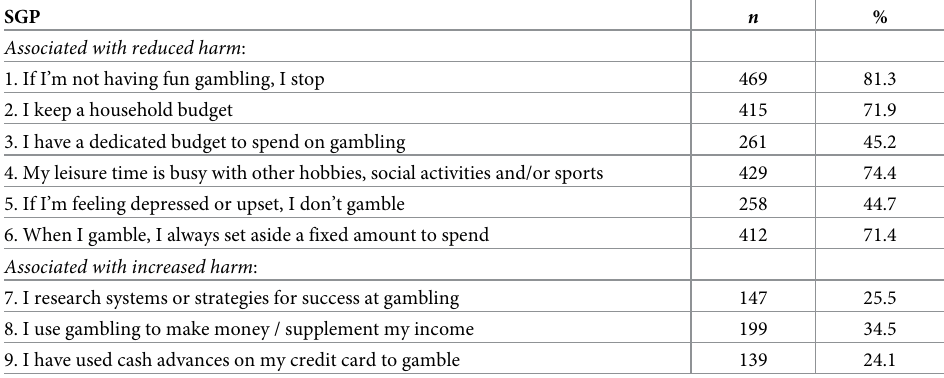
Table 4. Frequency of use for the most important SGPs amongst gamblers ( N = 577). SGP n % Associated with reduced harm